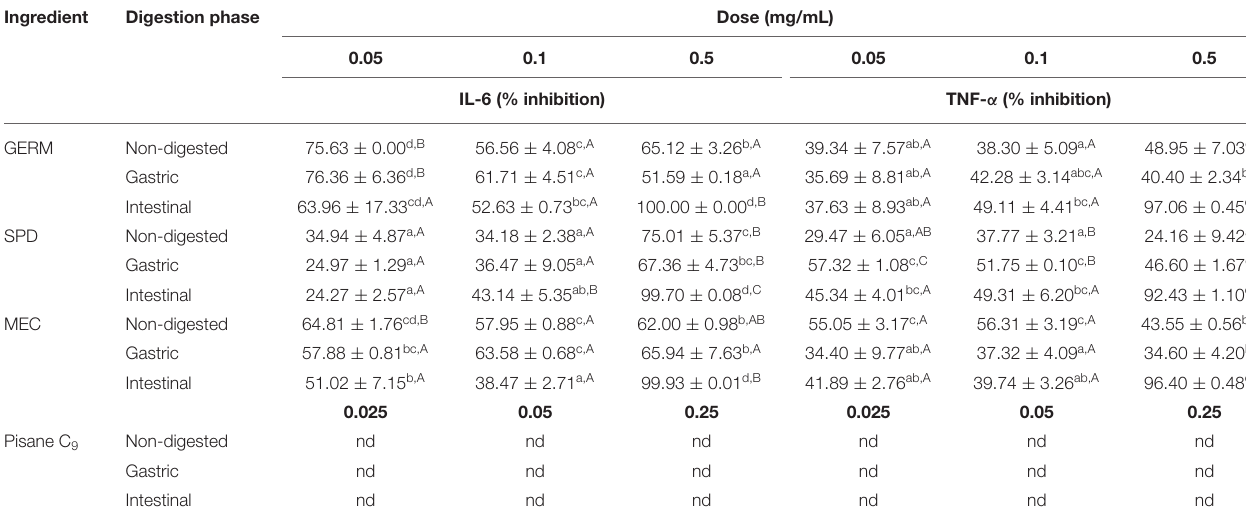
TABLE 7 | Effect of in vitro digestion on the anti-inflammatory activity of wheat ingredients.